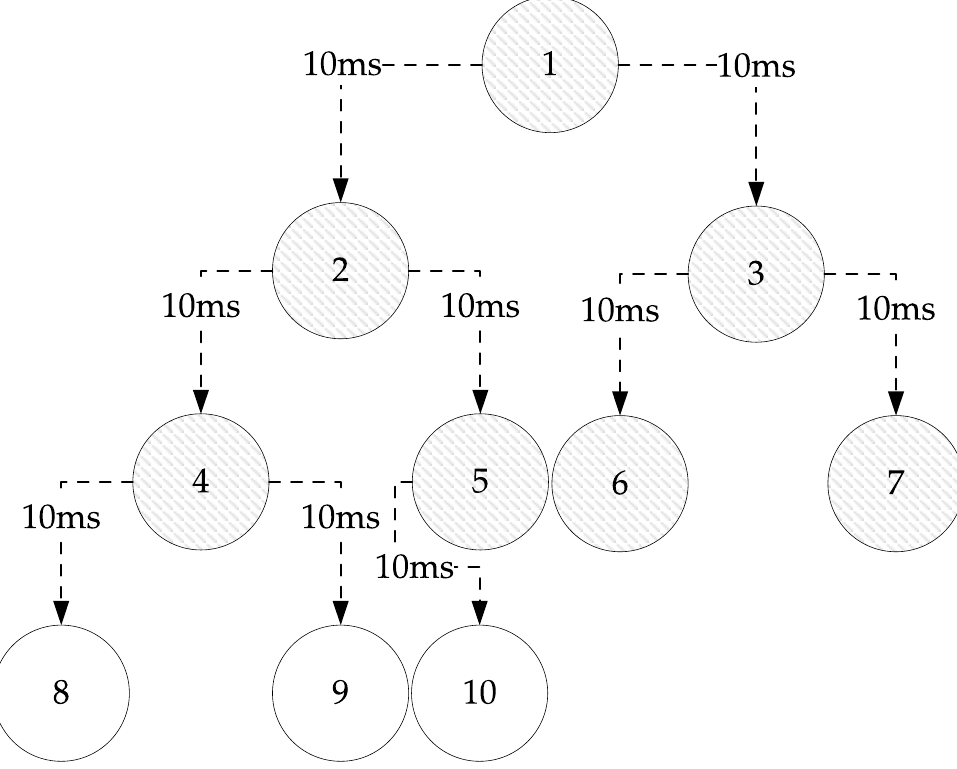
Figure 7. The proposed binary tree-structured lightweight blockchain.